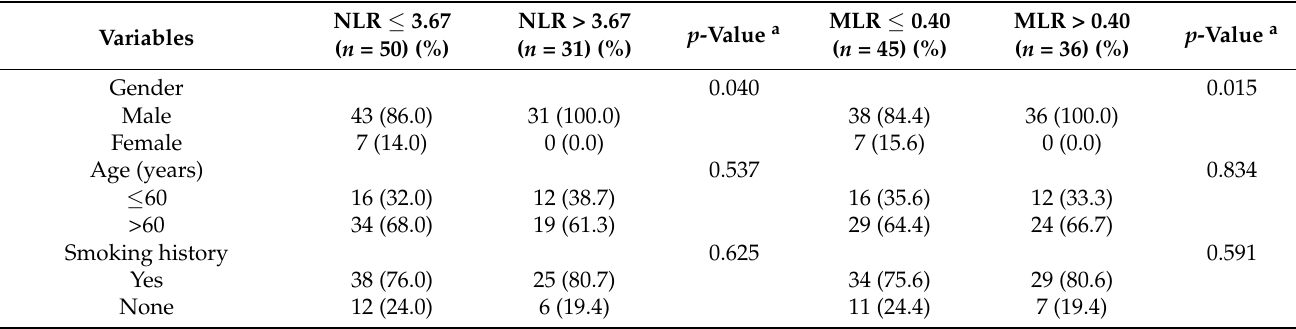
Table 2. Clinical variables of analyzed patients in different